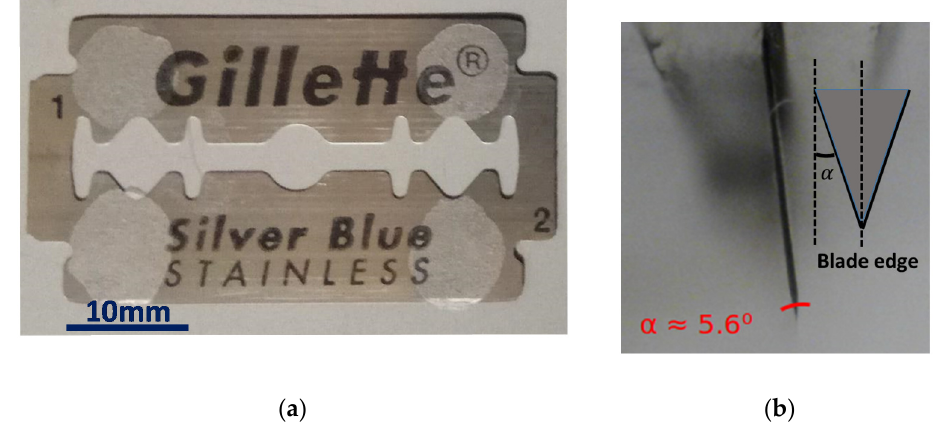
Figure 2. ( a ) Razor blade used for cleaving; ( b ) detailed view of the razor blade angle.